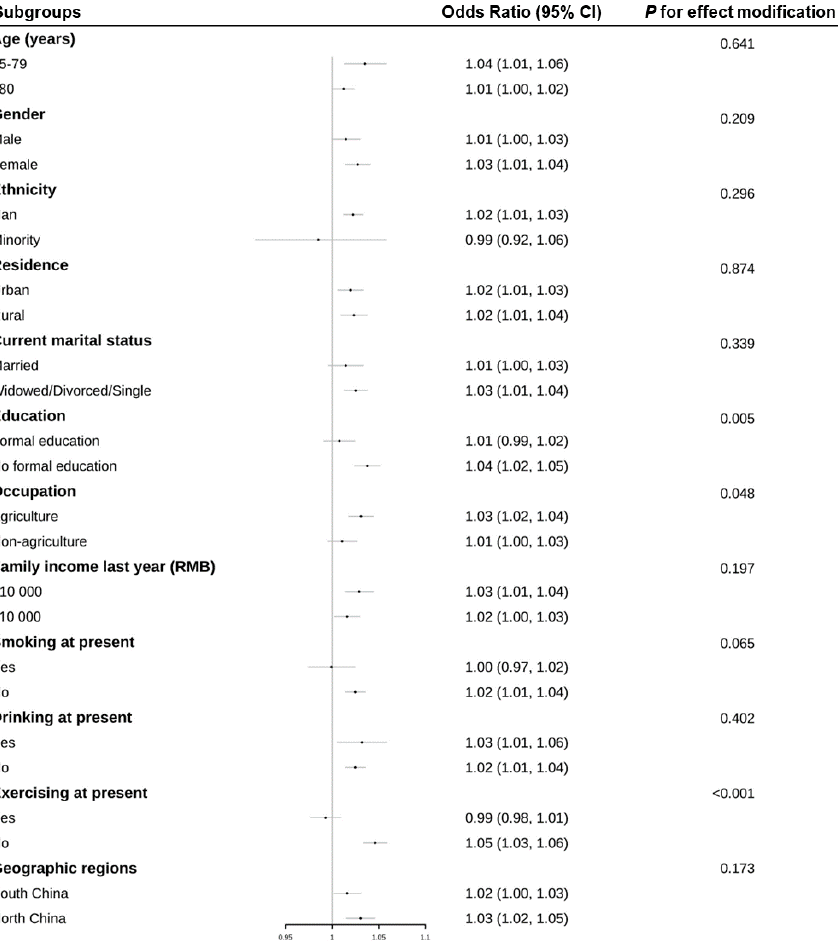
Figure 1. Restricted cubic splines for the associations between average temperature in January and frailty.